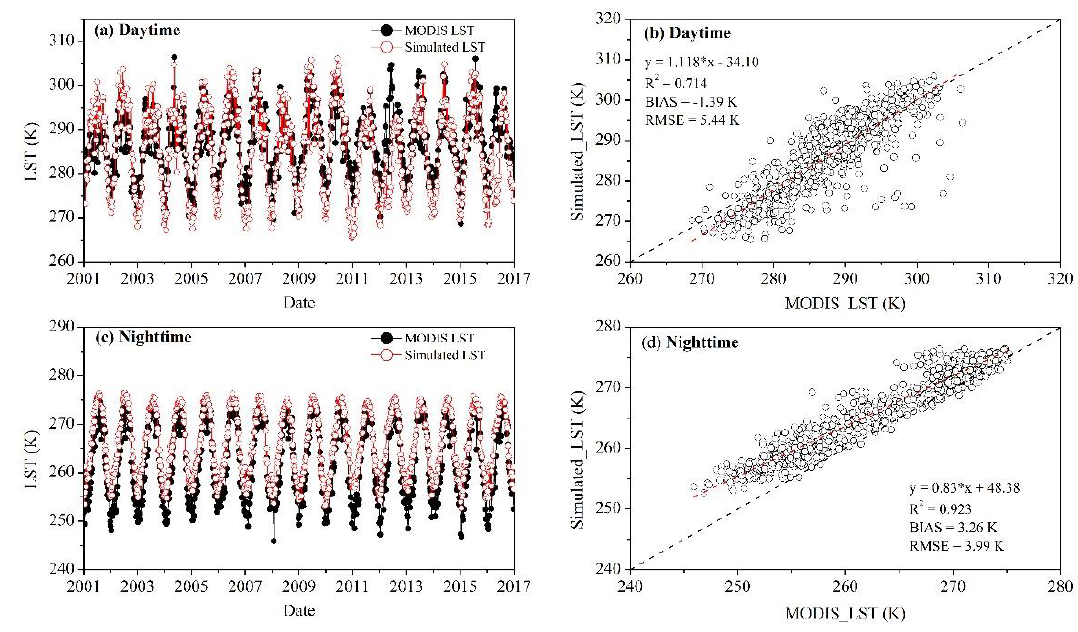
Figure 5. Comparison of 8-daily basin-averaged LSTs of Nam Co between model simulations and MODIS time-series in ( a ) daytime and ( c ) nighttime; scatterplots in ( b ) daytime and ( d ) nighttime during 2001–2016